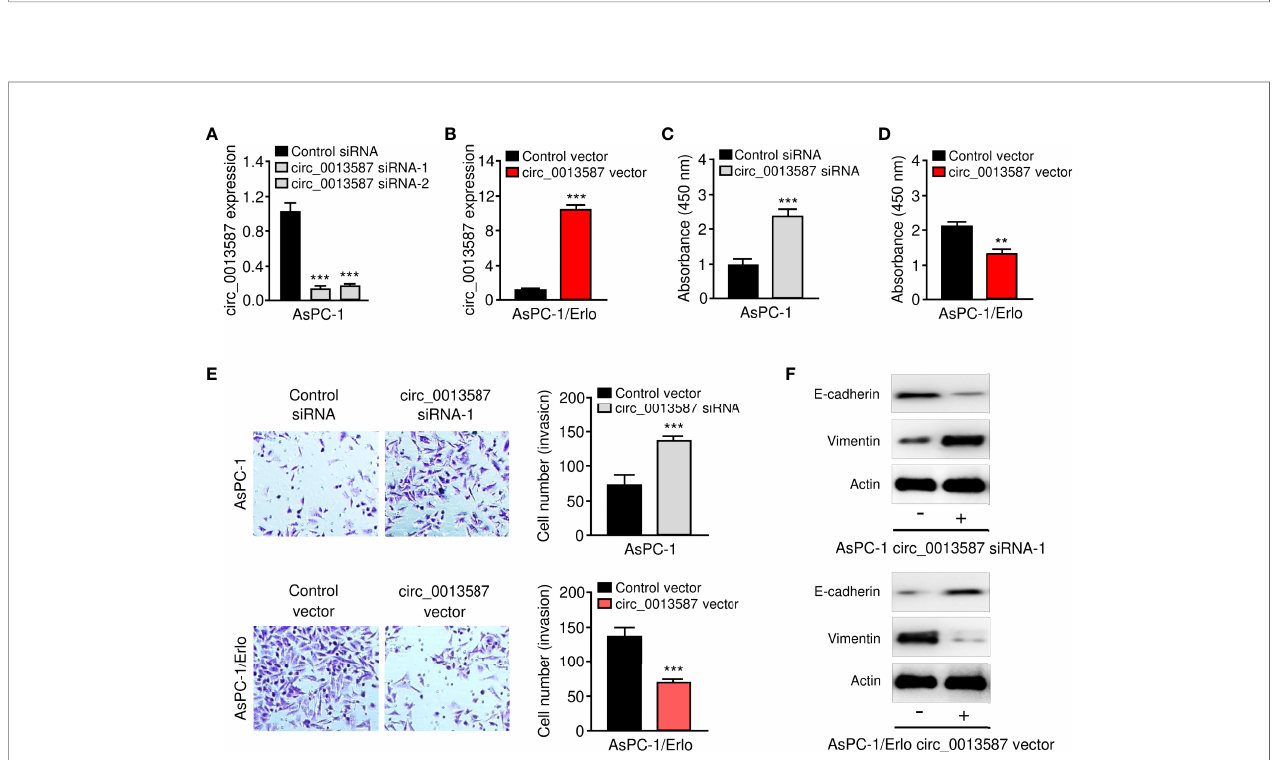
FIGURE 2 | Circ_0013587 represses proliferation and EMT of pancreatic cancer cells in vitro . (A) Quanti fi cation of circ_0013587 levels in AsPC-1 cells transfected with circ_0013587 siRNAs or control siRNA. (B) Quanti fi cation of circ_0013587 levels in AsPC-1/Erlo cells transfected with circ_0013587 vector or control vector. (C, D) CCK-8 assay in pancreatic cancer cells following knockdown (C) or overexpression (D) of circ_0013587. (E) Transwell invasion assays in pancreatic cancer cells after knockdown or overexpression of circ_0013587. (F) The expression of E-cadherin and Vimentin was examined in pancreatic cancer cells overexpressing or under-expressing circ_0013587 using western blot analysis. ** P < 0.01, *** P